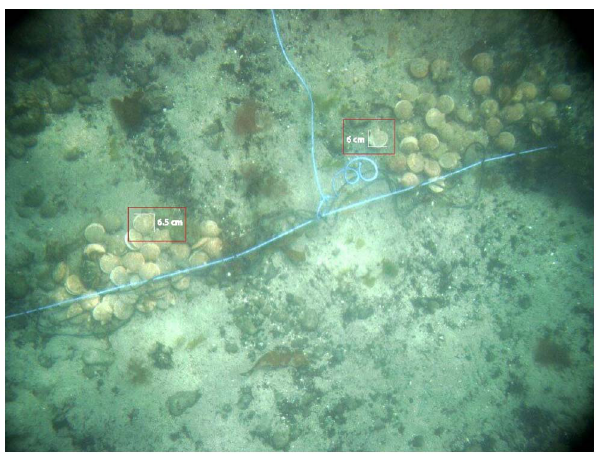
Figure 5. Iceland scallops photographed with a AUV camera at 1.94 m above the bottom, from the water surface. Approximate size scales, 6.0 and 6.5 cm, for known scallop sizes are also displayed. doi:10.1371/journal.pone.0109369.g005 ( x 2 ~ 0 : 1521 ) showing that the estimated lengths across the 5 repeated surveys were not significantly different i.e. there is no obvious inconsistency between the AUV surveys.